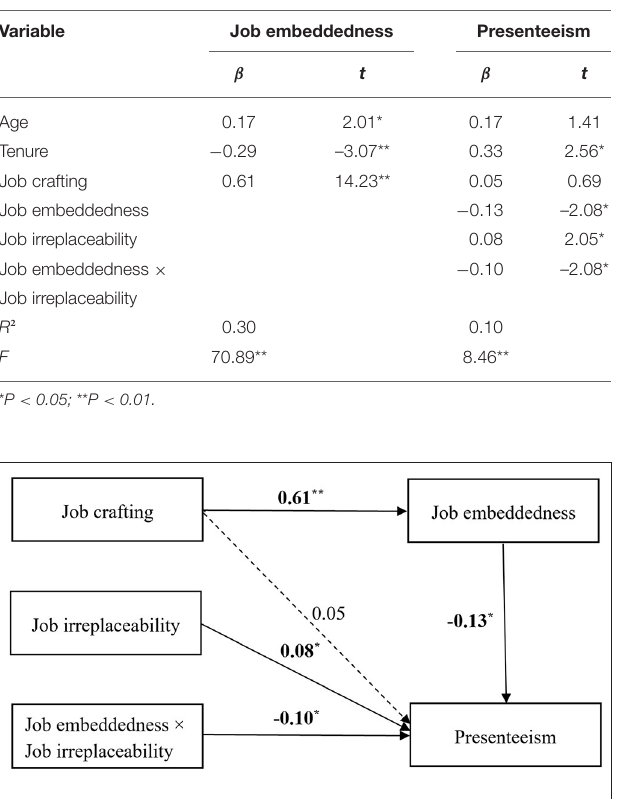
FIGURE 3 | Results of the moderated mediation